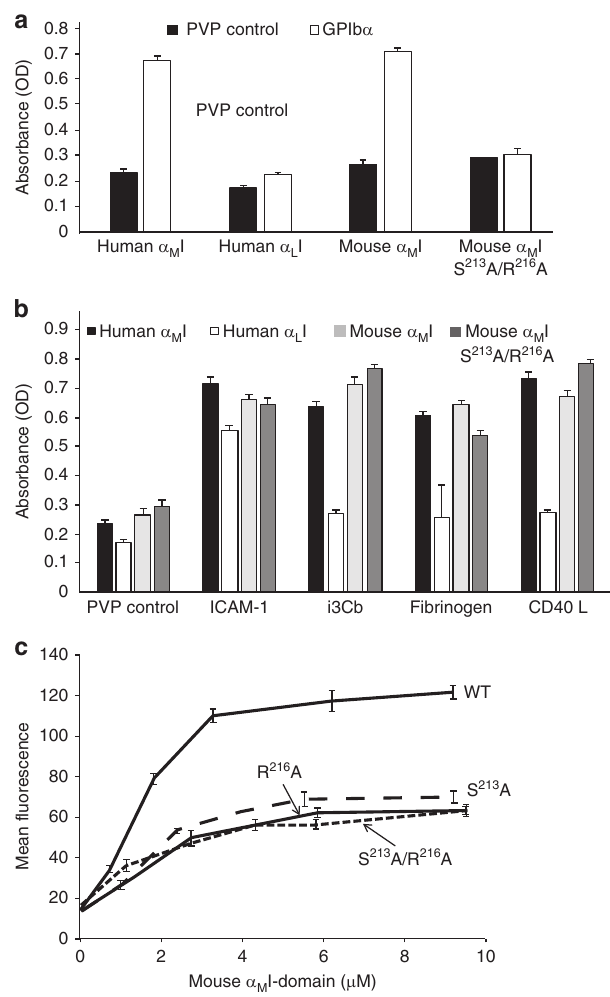
Figure 6 | a M I-domain binding to GPIb a and generation of muMac-1 (S 213 A/R 216 A) mice. ( a ) Binding of human a M and a L I-domains to soluble form of GPIb a was assessed in a solid phase assay. GPIb a was immobilized onto microtitre plates and wells were post-coated with PVP. After washing, the indicated I-domains were allowed to bind for 60min at 37 (cid:2) C, plates were washed and binding was detected with a HRP-labelled anti-GST (see Methods). ( b ) Binding of the various a M I-domain to the indicated immobilized ligands was detected as in a . a M and a L I-domains bind to different sites in ICAM-1; the binding of a L I-domain to ICAM-1 establishes its functionality. ( c ) Mouse a M I-domain fragments, WT, S 213 A, R 216 A and S 213 A/R 216 A, were expressed as GST-fusion proteins in E. coli , purified on glutathione–Sepharose, and labelled with Alexa-488. Platelets were isolated from mouse blood by differential centrifugation and incubated with the a M I-domains for 30min at room temperature. The platelets were then fixed with 2.5% glutaraldehyde in phosphate-buffered saline and analysed with a Facscan flow cytometer (Beckton-Dickenson), and mean fluorescence intensities were determined using the CellQuest software. Values for I-domain-free platelets were subtracted as the negative controls. Data are mean ± s.d. (error bars) from two to three independent experiments, and each experiment was performed in